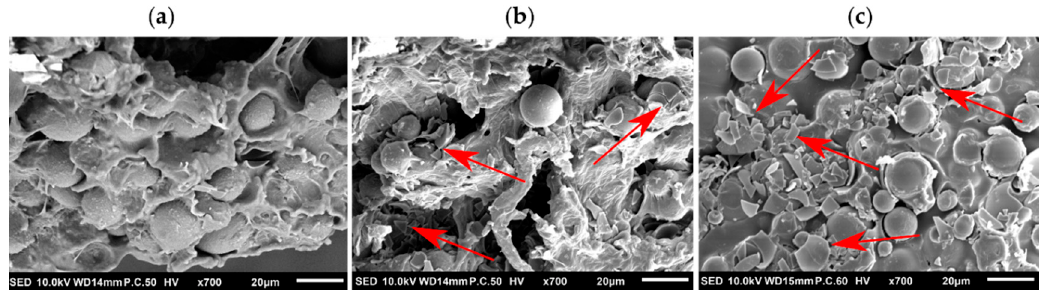
Figure 14. SEM micrograms of GB composite materials at 30 vol.% ( a ), 45 vol.% ( b ), and 60 vol.% ( c ).